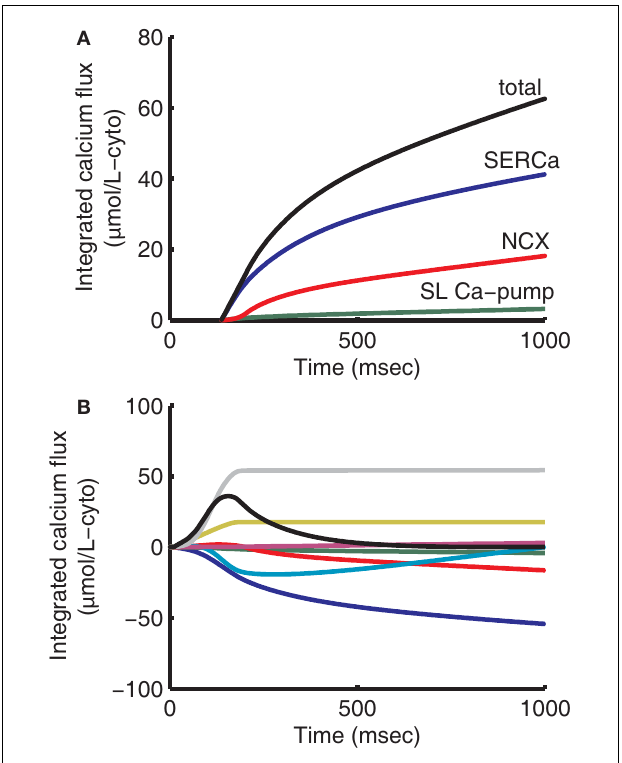
FIGURE 4 | Integrated cytosolic Ca 2 + fluxes. Cytosolic Ca 2 + uptake is given as the sum of SERCa, NCX, and sarcolemmal Ca 2 + -pump fluxes (A) . SERCa contributes 65.9% of uptake, NCX 28.9%, and SL Ca-pump 5.1%. In this model mitochondria contribute significant beat-to-beat buffering.The mitochondrial uniporter predominates during the first 300ms of the cycle, resulting in a net uptake of Ca 2 + from the cytosol (B) . For the remainder of the cycle, mitochondrial Na + -Ca 2 + exchanger predominates, resulting in Ca 2 + being transferred back out of the mitochondria to the cytosol.The mitochondria release an amount of Ca 2 + equal to 12.7% of the net integrated Ca 2 + uptake flux into the cytosol during relaxation. Integrating over the entire 1000ms period (B) , fluxes into the cytosol are given as positive and fluxes removing Ca 2 + from the cytosol are negative. Fluxes shown represent SERCa (blue), NCX (red), SL Ca-pump (green), mitochondria (teal), background Ca 2 + current (magenta), L-type Ca 2 + current (yellow), SR release (gray), and total